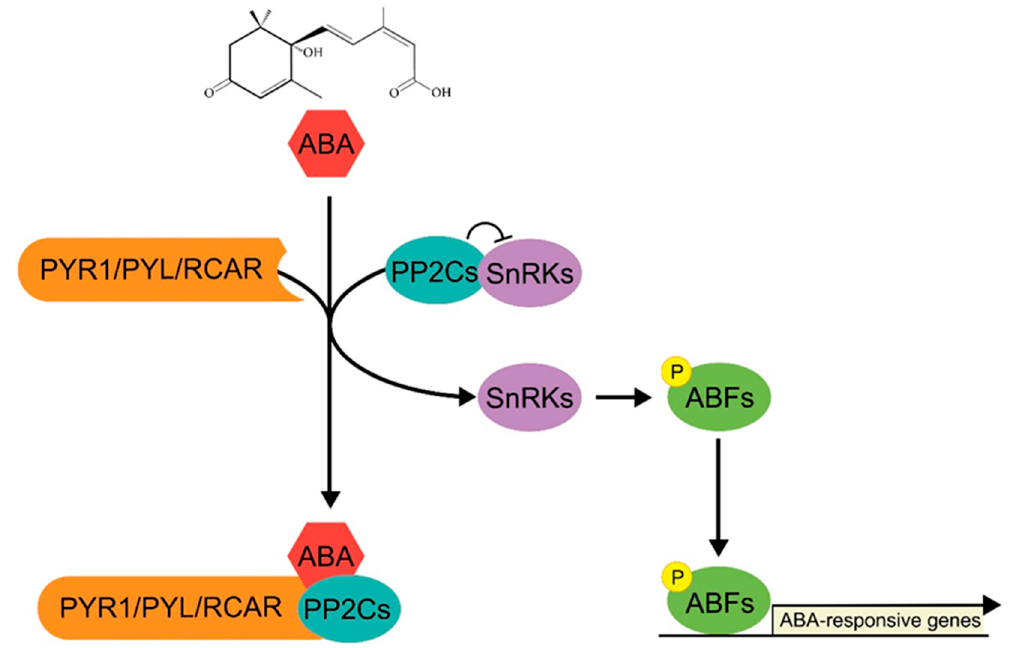
Figure 1. A schematic of ABA signaling pathway. In response to ABA, ABA receptor PYR1 / PYL / RCAR forms a complex with PP2Cs, and activates SnRKs, the kinases that determine the activity of ABF transcription factors. SnRK-mediated phosphorylation of ABF promotes expression of ABA-responsive genes and ABA response.